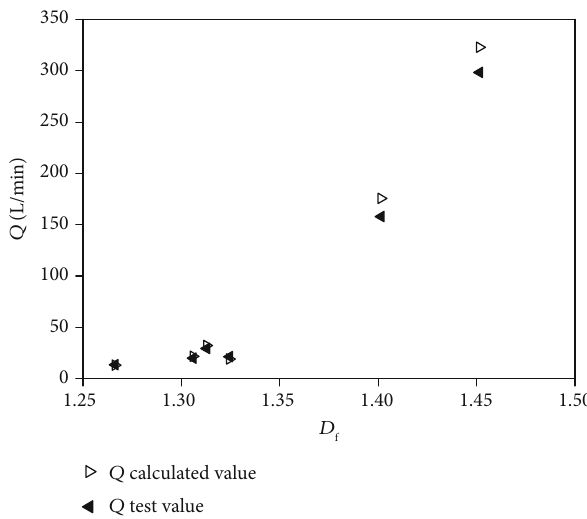
Figure 21: Comparison of theoretical model and water injection test Q .